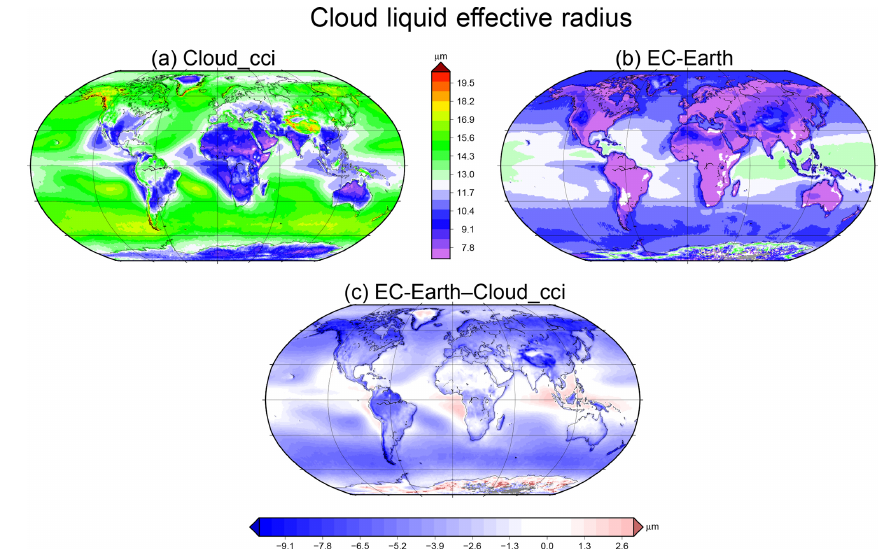
Figure 9. Same as for Fig. 8 but for liquid r e